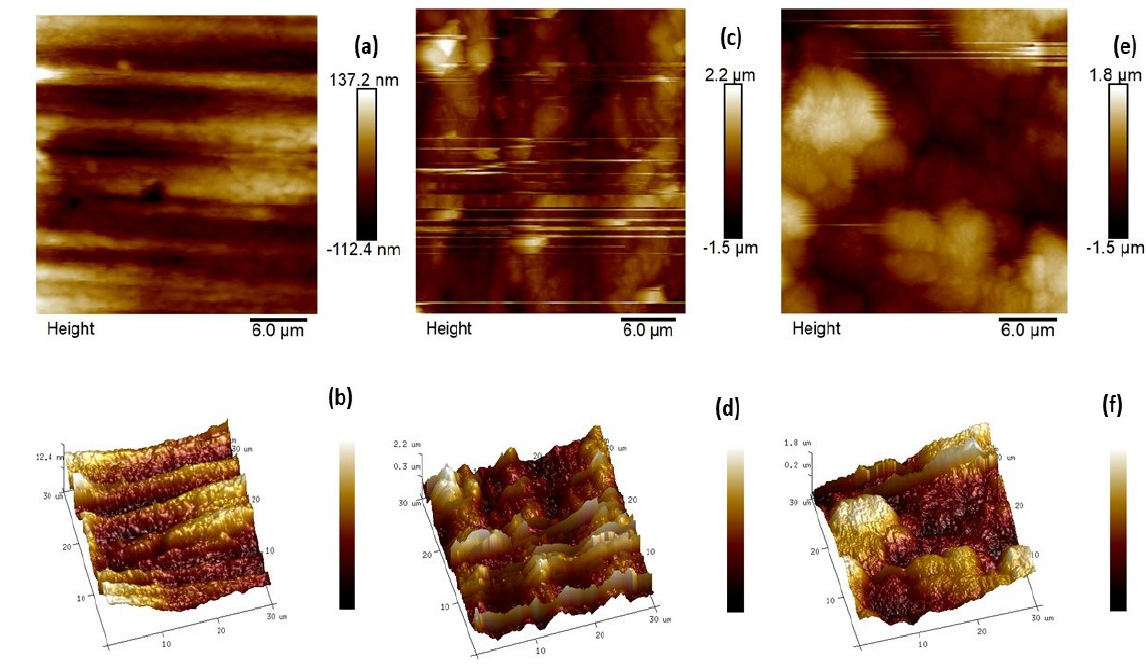
Figure 10. 2-D and 3-D AFM micrographs for Mild steel ( a , b ). Polished sample. ( c , d ) Blank sample and ( e , f ) sample + 0.6163 mM CMEA in 1 M HCl. Table 6. Results of CMEA-inhibited AFM investigation of